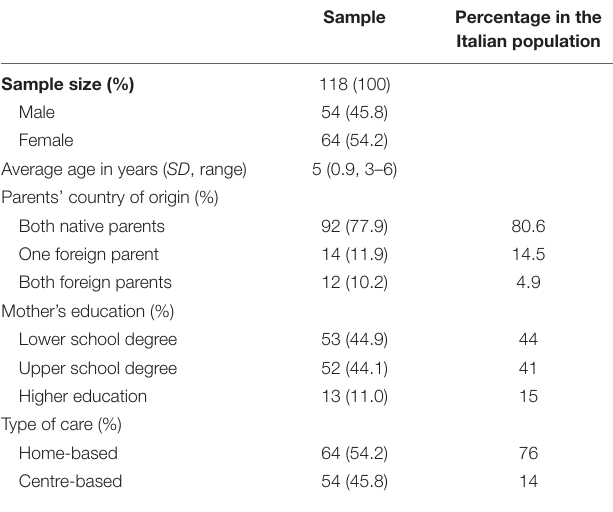
TABLE 1 | Characteristics of the sample.